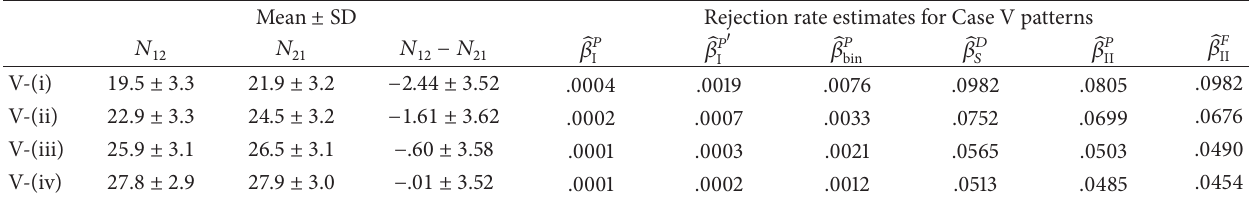
Table 11: The means ( ± SD) of the off-diagonal entries, 𝑁 12 , 𝑁 21 , and their difference 𝑁 12 − 𝑁 21 and the rejection rate estimates for Case V = 10000 , 𝑛 = 𝑛 = 40 at 𝛼 = .05 . Column labeling is as in Table 6. patterns with 𝑁 1 2 mc Mean ± SD Rejection rate estimates for Case V patterns